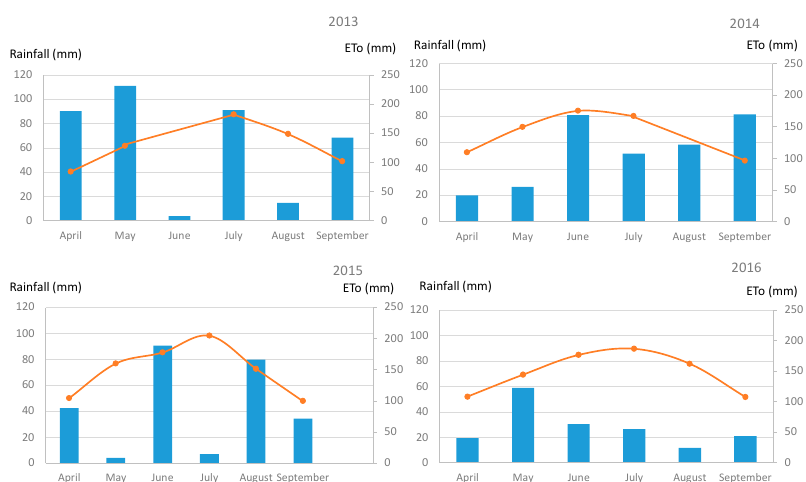
Figure 2. Principal climatic features for the four years of the study. The blue bars represent cumulated rainfall levels and the orange lines indicates evapotranspiration (ETo) by month during the production season from bud burst (April) to harvest